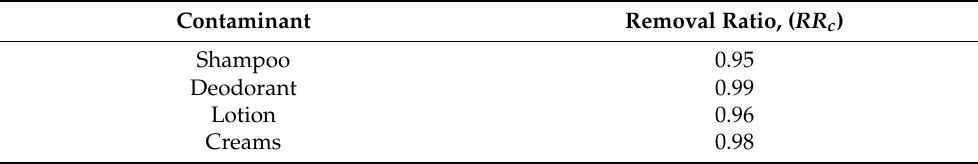
Table A13. Contaminant removal ratio for case study 4